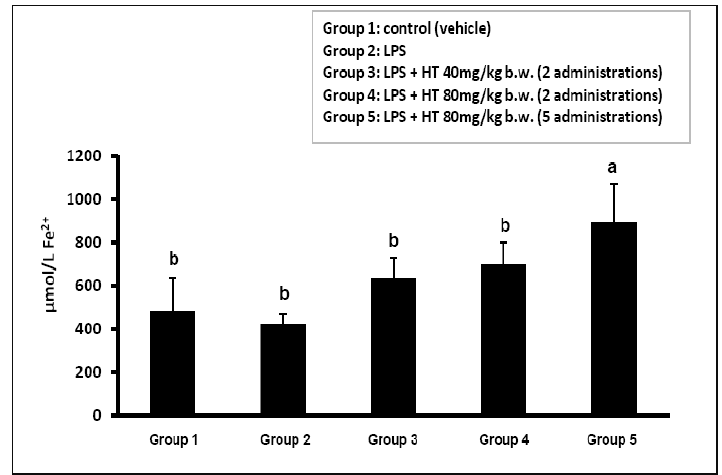
Figure 3. Effect of LPS and HT on antioxidant power of plasma in mice. 100 µ L/mouse of plasma were used to determine the antioxidant ability of plasma by FRAP test. Data are expressed as µ mol/liter of Fe 2+ Each bar represents the mean ± S.D. of values obtained from the 8 mice/group. Bars with a different letter are significantly different, p < 0.05.